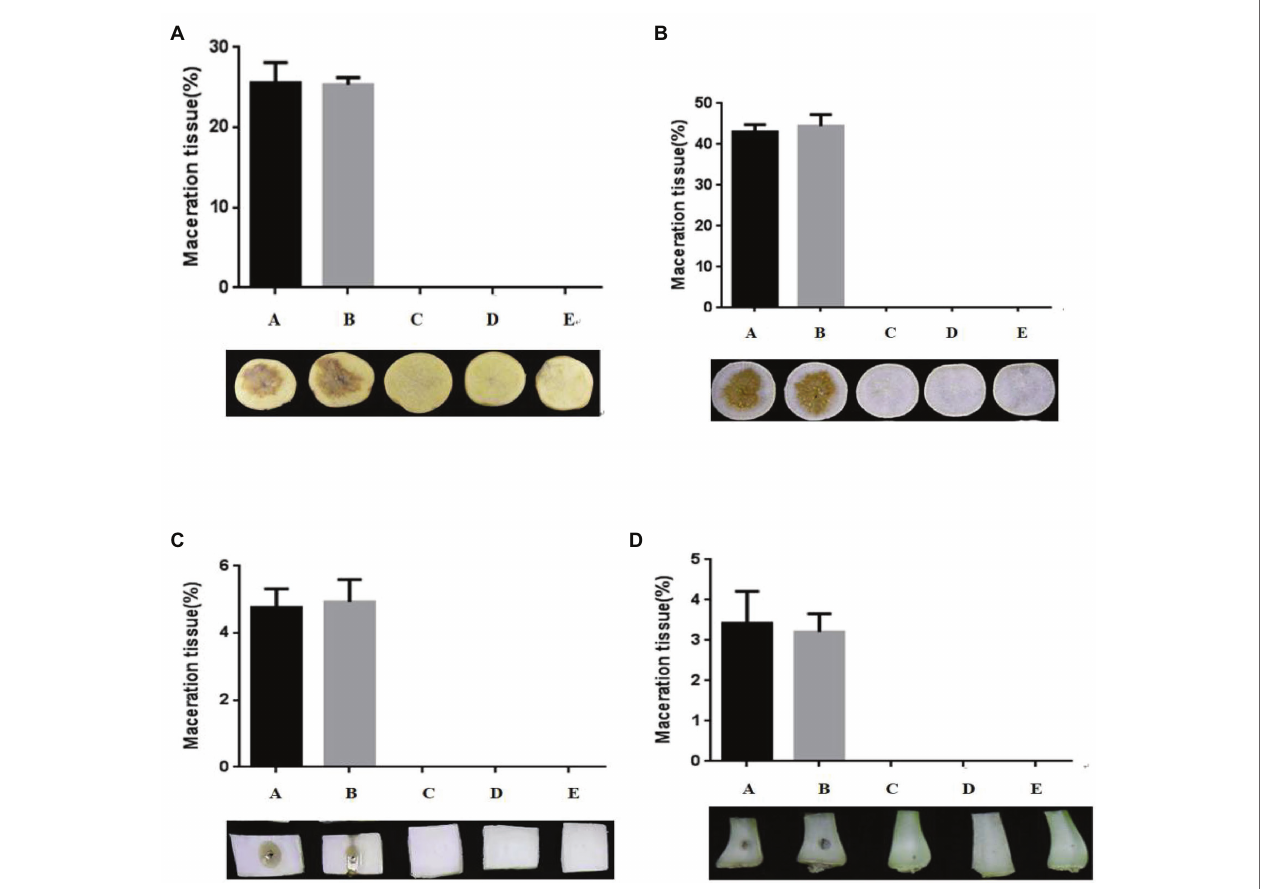
FIGURE 4 | Test of strain W-7’s ability to attenuate maceration from soft-rot disease in plant slices. (A) potato ( Solanum tuberosum L.); (B) radish ( Raphanus sativus L.); (C) Chinese cabbage [ Brassica pekinensis (Lour.) Rupr.]; (D) pakchoi ( Brassica campestris L. ssp. chinensis Makino). Panel A, EC1 alone on plant slices; Panel B, EC1 + Escherichia coli DH5 α ; Panel C, EC1 + B23; Panel D, EC1 + agricultural streptomycin; Panel E, EC1 +